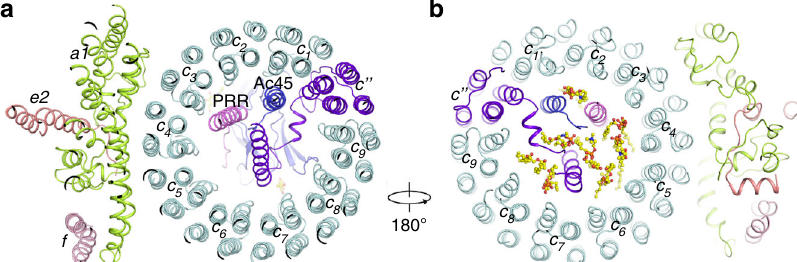
Fig. 3 Structure of the Vo domain with its associated lipids. a Overall structure showing the Vo domain. b The luminal view of the Vo domain in state 1 showing the lipids that are involved in the Vo assembly. The putative PCs are shown in yellow